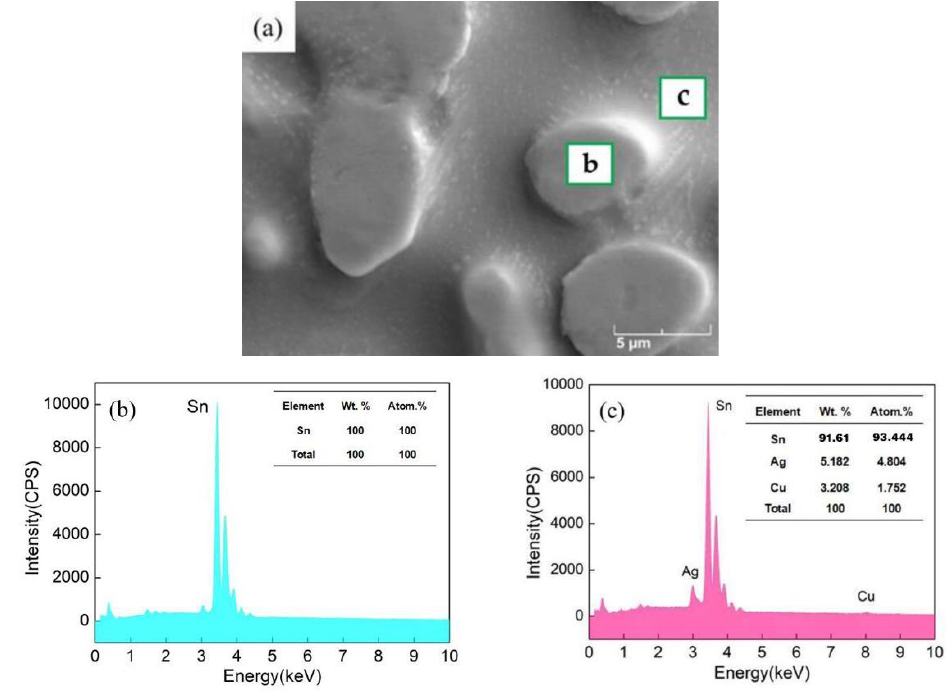
Figure 3. ( a ) Zoomed view of humps ( b ) and matrix ( c ); EDS experiments of ( b ) humps and ( c ) matrix.